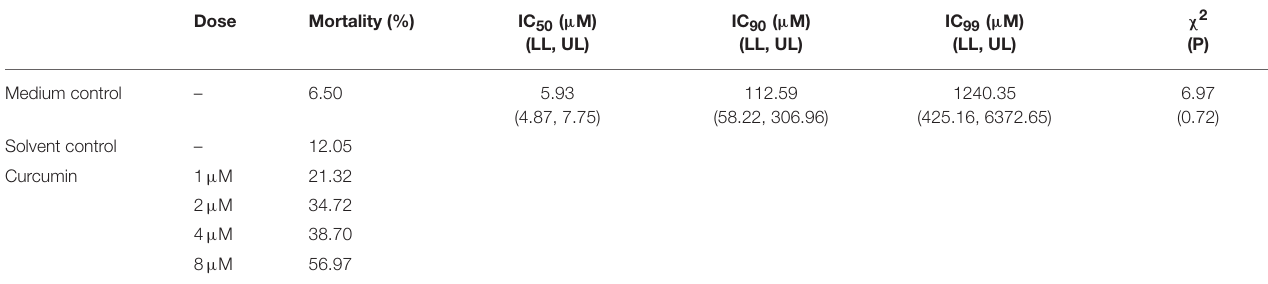
TABLE 1 | Effects of curcumin treatments on B. besnoiti tachyzoite viability. Dose